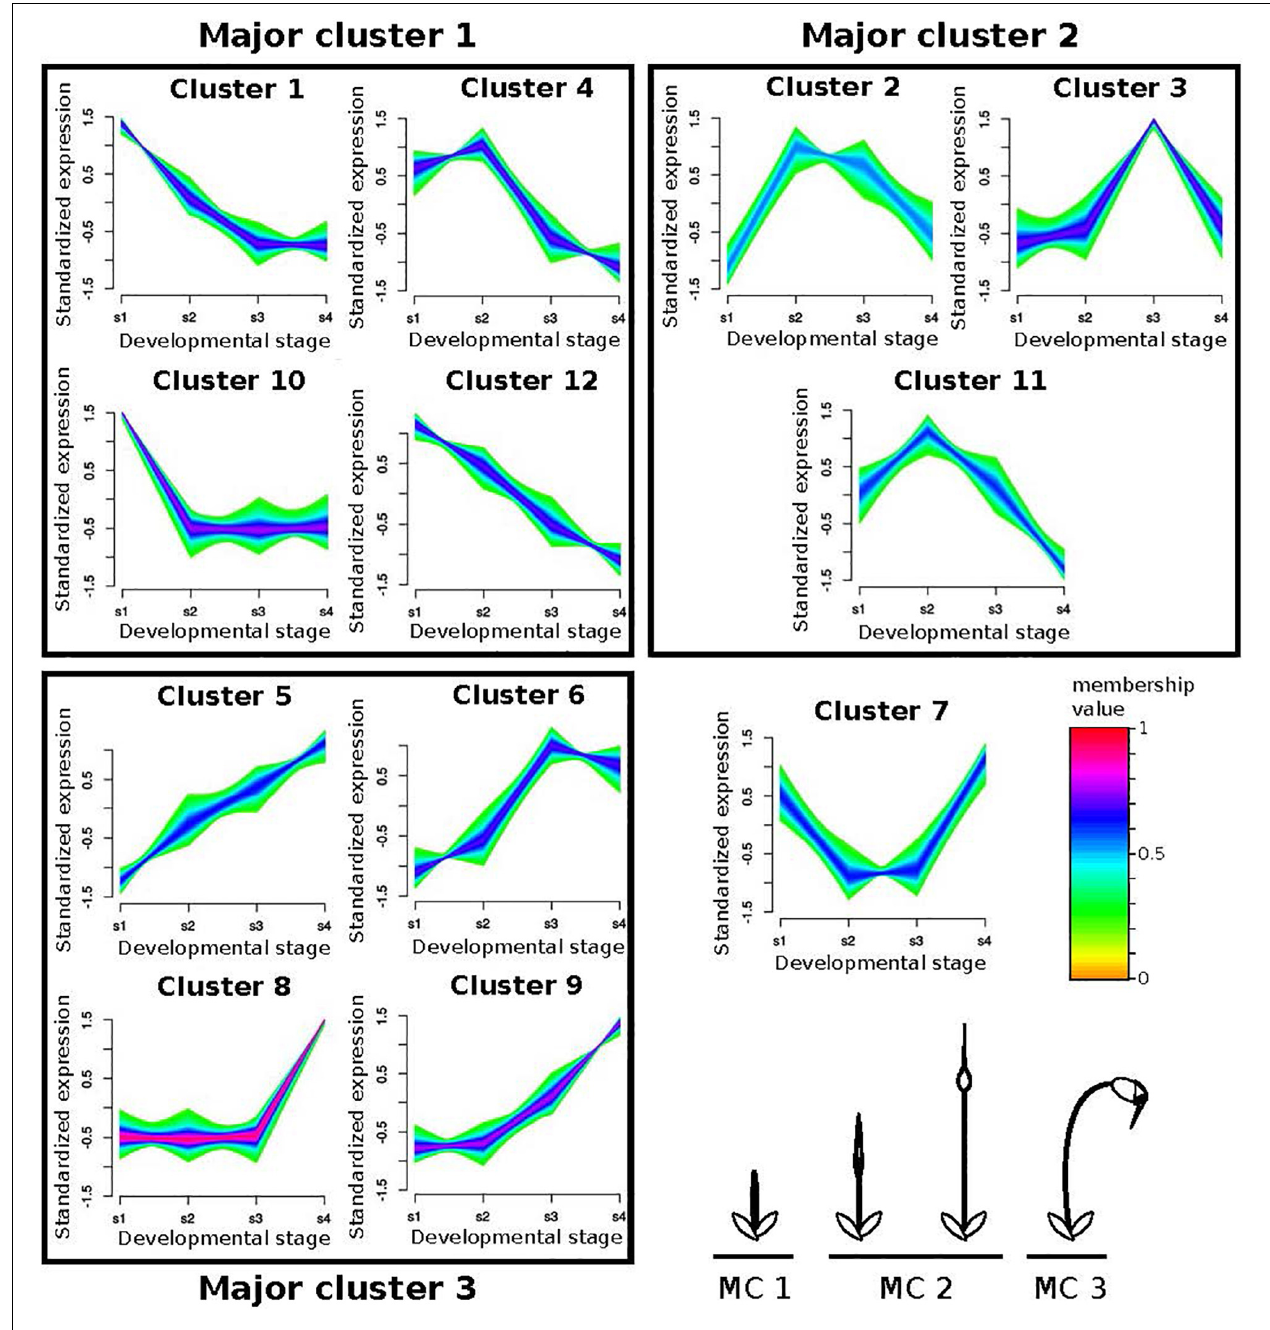
FIGURE 5 | Fuzzy clustering of gene expression data from 4 stages of sporophyte development of Funaria hygrometrica and Physcomitrium patens . We identified 12 clusters with distinct expression profiles. For each cluster, relative expression changes of the assigned genes are shown together with their color-coded membership values, indicating how strong their expression pattern correlates with the cluster core. The clusters are further condensed to Major clusters (MC), depending on whether expression peaks occurred during early (MC 1), intermediate (MC 2), or late (MC 3) sporophyte development (bottom right). Cluster 7 could not be assigned to one of the major clusters. s1 – s4: sporophyte developmental stages 1 to